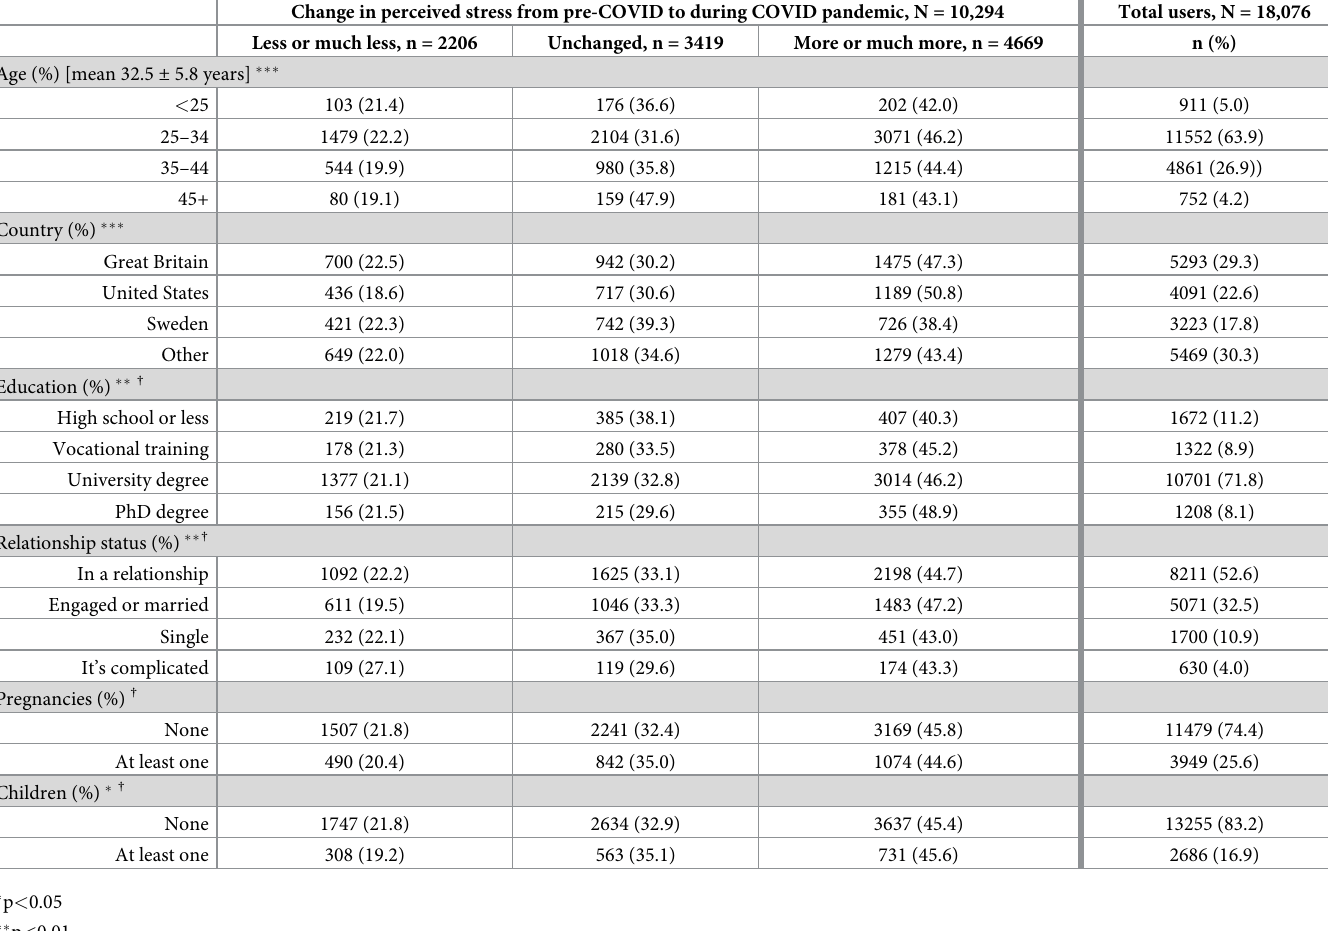
Table 1. Characteristics of natural cycles users contributing at least two cycles of data prior to and during the COVID-19 pandemic (n = 18,076 users; N = 214,426 cycles). Change in perceived stress from pre-COVID to during COVID pandemic, N =